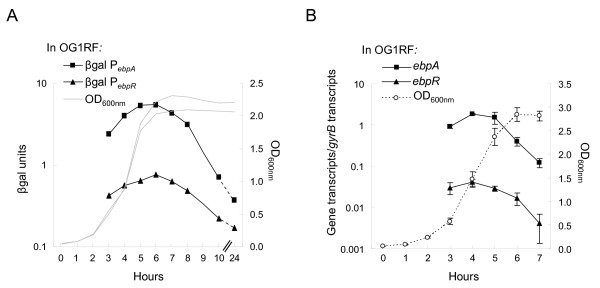
ebpR and ebpA expression profiles in OG1RF. A. Expression levels of ebpA and ebpR using gene promoter::lacZ fusions. OG1RF containing either PebpR::lacZ (black triangle) or PebpA::lacZ (black square) were grown in TSBG. For β-gal assays, samples were collected every hour from 3 to 8 hr, then at 10 and 24 hr after starting the culture (x axis). The left axis represents the β-gal units (OD420 nm/protein concentration in mg/ml). The right axis indicates the OD600 nm readings. All sets of cultures presented were analyzed concurrently. This figure is a representative of at least three independent experiments. B. qRT-PCR with RNA purified from OG1RF cultures grown aerobically in TSBG. The left axis represents the level of transcript normalized to gyrB transcript level. The right axis indicates the OD600 nm readings. The dashed line shows the mean (with standard deviation) of 5 independent cultures of OG1RF grown in TSBG. The transcript levels of ebpR (black triangle) and ebpA (black square) shown represent two different data sets, each tested in duplicate that were normalized using gyrB transcript levels.